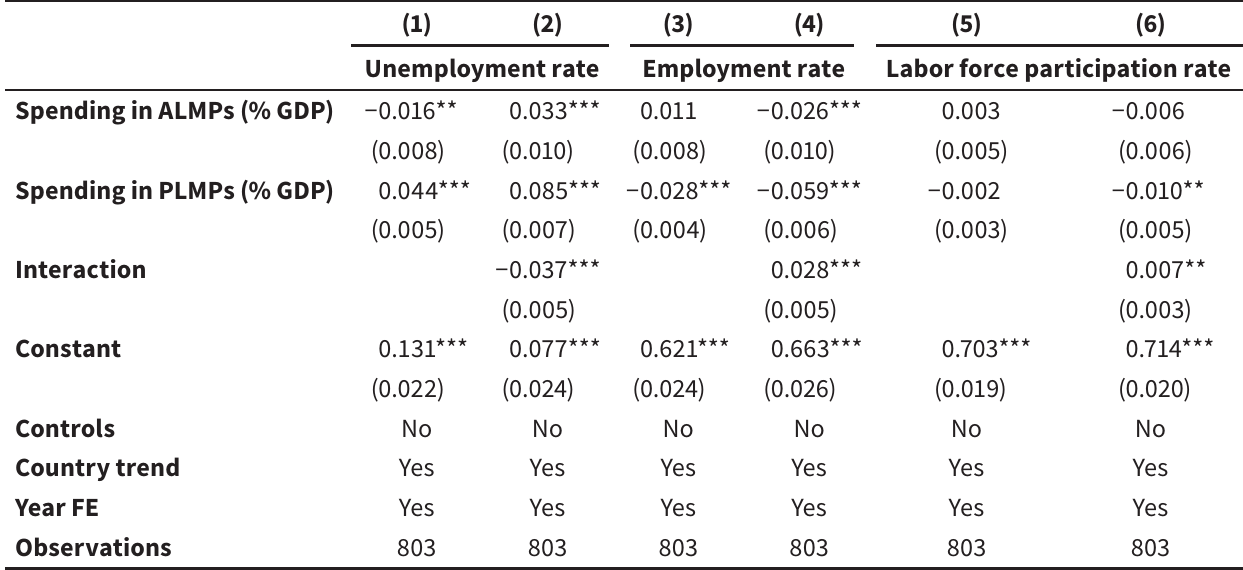
Results for the robustness test using the lagged value of spending as an